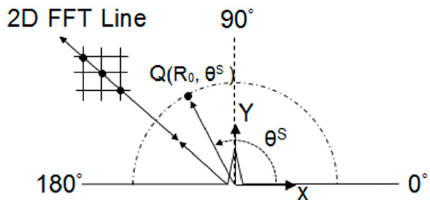
Figure 2. Diagram of a crack on top of the racecourse shaped hole showing 2D fast Fourier transformation (2D FFT) of signal measurement for scattered wave measurements.